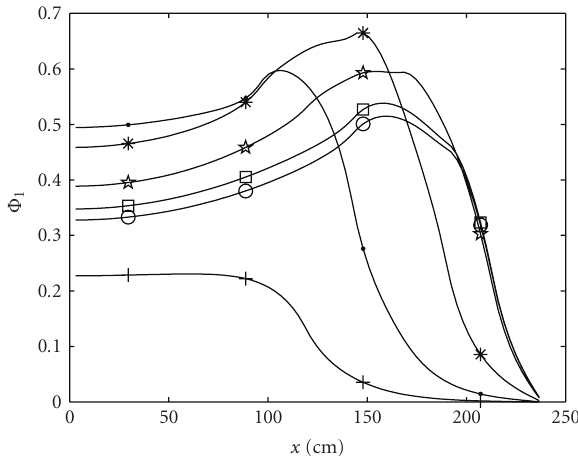
Figure 4: Graphs of the first-group (high energy) fluxes. Symbols on curves identify fluxes plotted along the transverses bearing the same symbol indicated in Figure